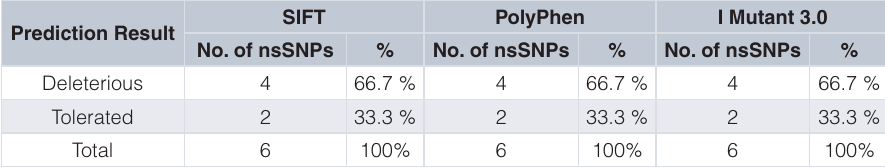
Table 5. The Prediction Results of nsSNPs of human TP53 Using SIFT, PolyPhen and I-Mutant 3.0 algorithms.